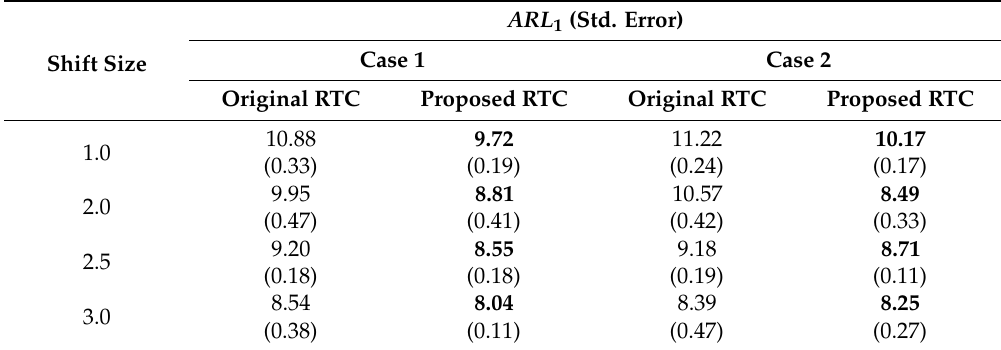
Table 3. Experimental results, dimension size = 50, window size = 10.